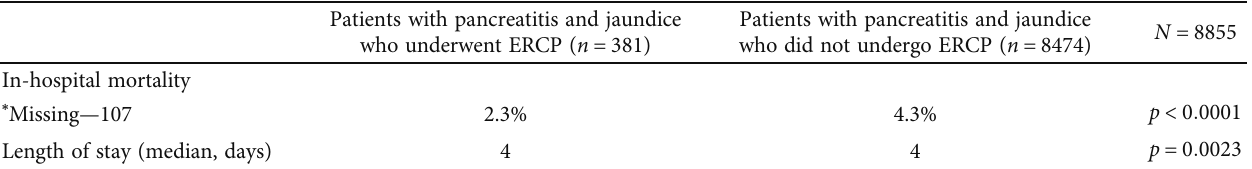
Table 3: Outcome comparison between those patients who underwent ERCP versus those who did